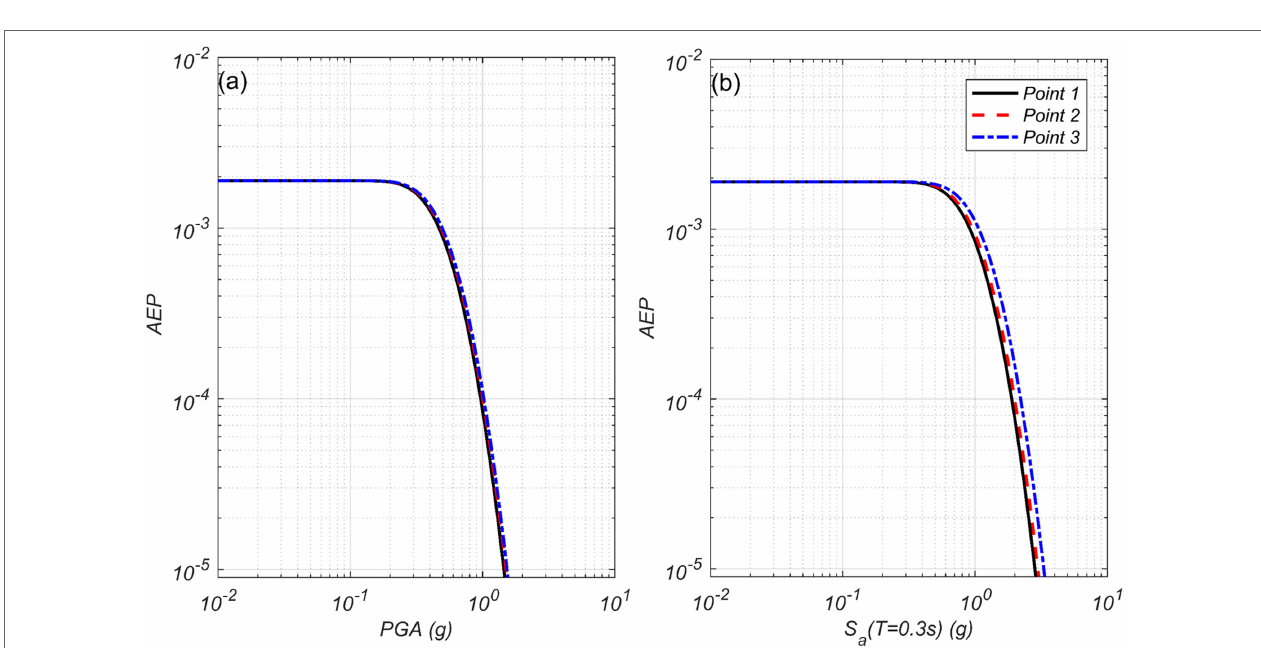
FIGURE 8 | Annual exceedance probability (AEP) for peak ground acceleration (PGA) (A) and S a ( T 1 = 0.3s) (B) at Points 1 (black solid), 2 (red dash), and 3 (blue dash-dot) for the full-rupture scenarios.